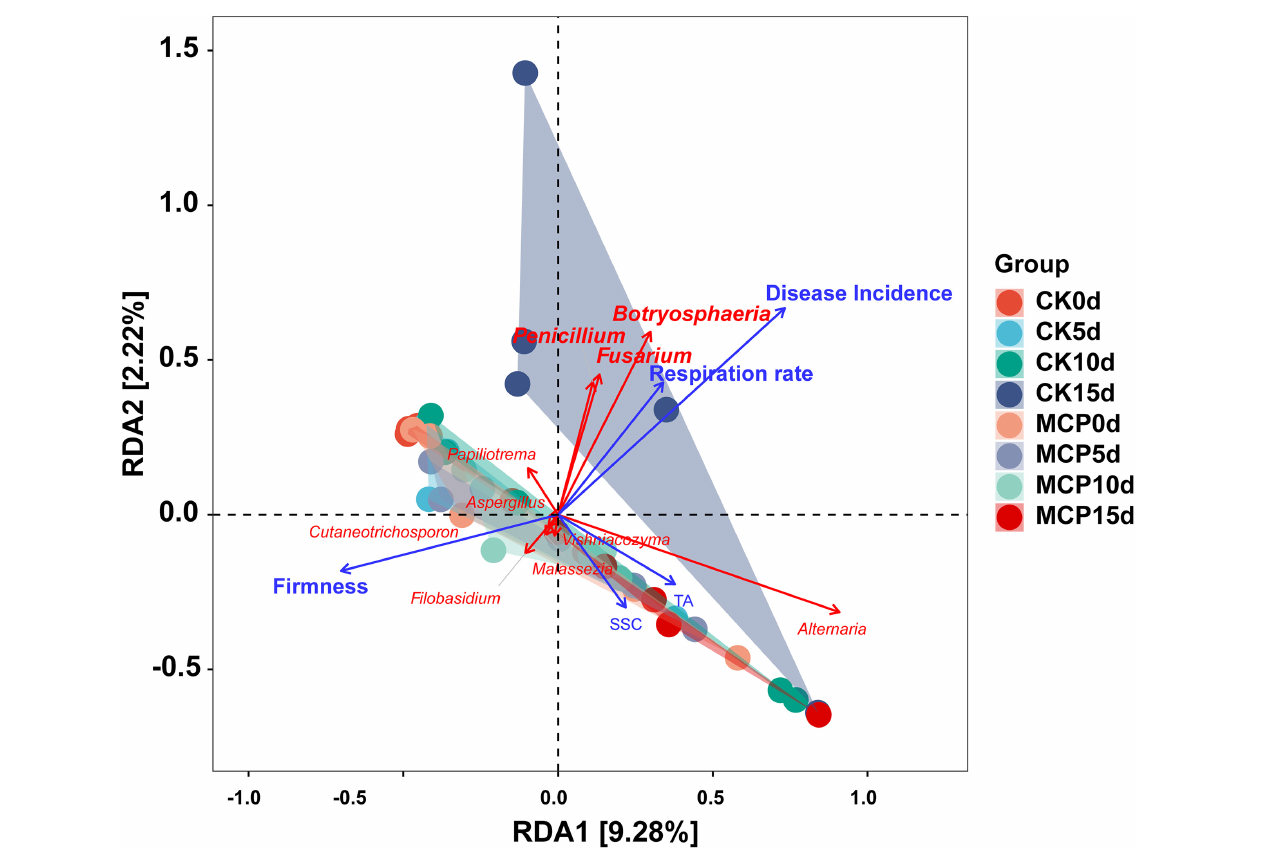
FIGURE 6 | Redundancy analysis (RDA) ordination graph for pear ( Pyrus communis L.cv. “Doyenne du Comice”) fruit quality, physiological characteristics, and fungal community diversity. Ten most abundant fungal genera (red arrows) and four fruit quality factors (blue arrows) including disease incidence, firmness, soluble solid content (SSC), TA, and respiration rate were plotted. Angles between species and fruit quality factors represent the positive and negative correlation between them (acute angle: positive correlation; obtuse angle: negative correlation; right angles: no correlation). This result indicates the important effect of Botryosphaeria , Penicillium and Fusarium on disease incidence, respiration rate, and firmness during the ripening of